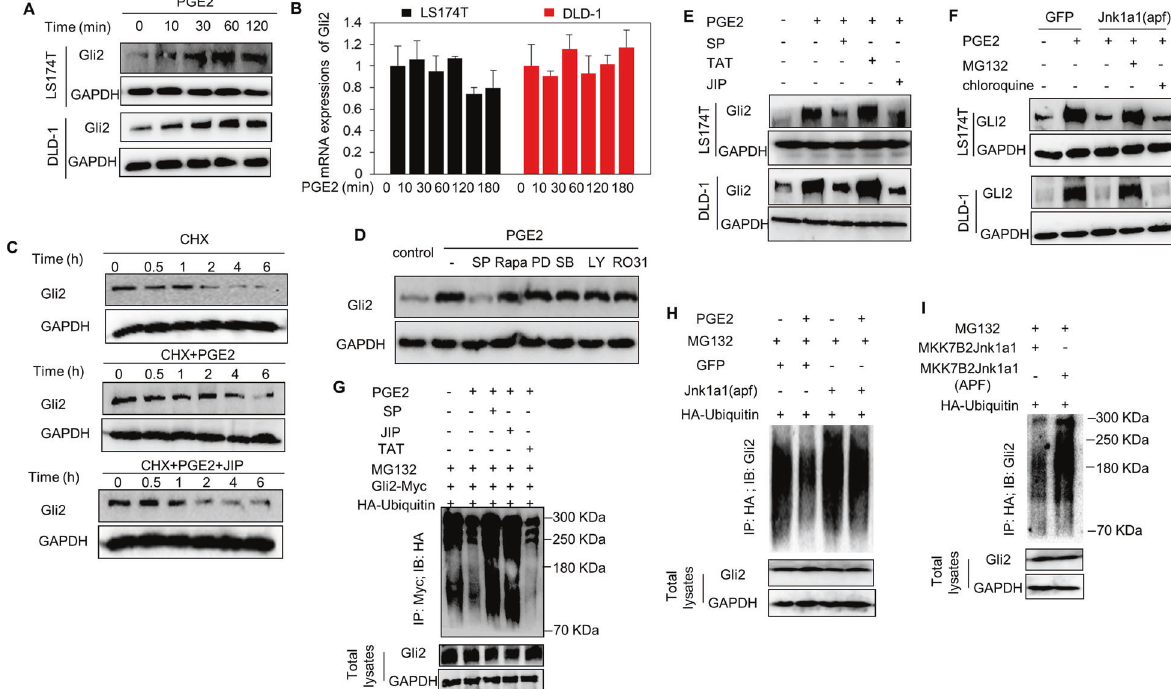
Fig. 2 PGE2 protects Gli2 from ubiquitin-proteasomal degradation by activating JNK. A Expression of Gli2 protein in LS174T and DLD-1 cells treated with PGE2 for different time intervals as indicated was analyzed by western blotting. B The mRNA level of Gli2 in LS174T and DLD- 1 cells treated with PGE2 for different time intervals was examined by real-time PCR and normalized to the mRNA level of gusb . Error bars represent SD ( n = 3). C Expression of Gli2 protein in LS174T cells treated with CHX (10 μ g/ml), PGE2 (1 μ M), and JIP (2 μ M) as indicated for different time intervals was analyzed by western blotting. D Immunoblot analysis of Gli2 protein expression in LS174T cells treated with PGE2 (1 μ M) in combination with SP (10 μ M), Rapa (100 nM), PD (10 μ M), SB (10 μ M), LY (10 μ M), RO31 (1 μ M) for 1 h, respectively. E Immunoblot analysis of Gli2 protein expression in LS174T and DLD-1 cells treated with PGE2 with or without SP, TAT, and JIP as indicated for 1 h. F Immunoblot analysis of Gli2 protein expression in LS174T and DLD-1 cells. Cells were transiently transfected with GFP or Jnk1a1(apf), followed by exposure to PGE2 with or without MG132 (10 μ M), and chloroquine (10 μ M) as indicated for 1 h. G Immunoprecipitation-western blot analysis of the ubiquitination of Gli2 (detected with anti-HA) in LS174T cells expressing HA-tagged ubiquitin, and Myc-tagged Gli2 with various combinations of treatment with PGE2, SP (10 μ M), JIP (2 μ M), TAT (2 μ M), and MG132 (10 μ M) as indicated 1 h. H Immunoprecipitation- western blot analysis of the ubiquitination of Gli2 (detected with anti-Gli2) in LS174T cells expressing GFP, Jnk1a1(apf), and HA-tagged ubiquitin with various combinations of treatment with PGE2, and MG132 as indicated for 1 h. I Immunoprecipitation-western blot analysis of the ubiquitination of Gli2 (detected with anti-Gli2) in LS174T cells expressing MKK7B2Jnk1a1, MKK7B2Jnk1a1 (APF), and HA-tagged ubiquitin after exposure to MG132 as indicated for 1